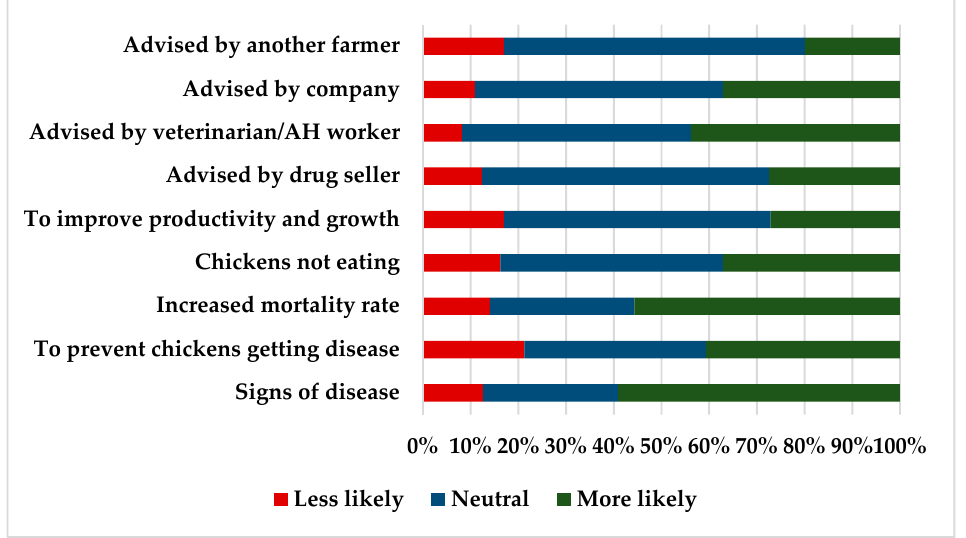
Figure 4. The behavioral influences behind antimicrobial use in a case study on antimicrobial use on broiler farms in Indonesia (n = 419).